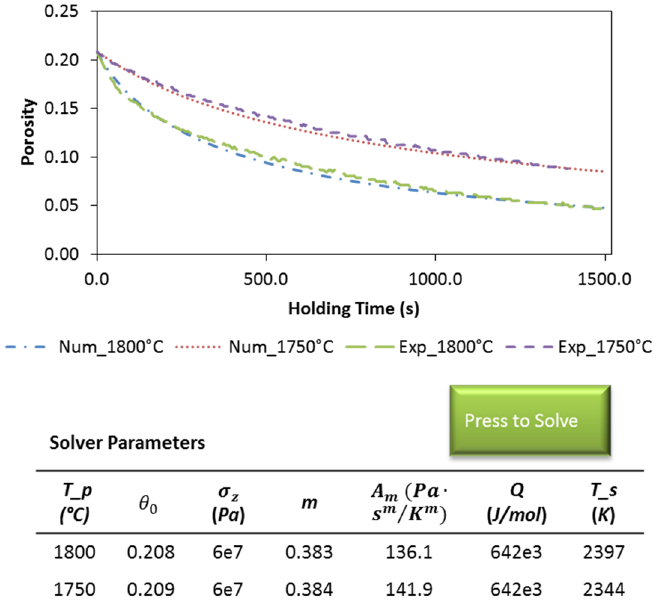
Figure 6. Numerical solver embedded spreadsheet interface: inverse regression of experimental data obtained from the holding stages in single-die SPS at 1800 °C and 1750 °C, respectively.